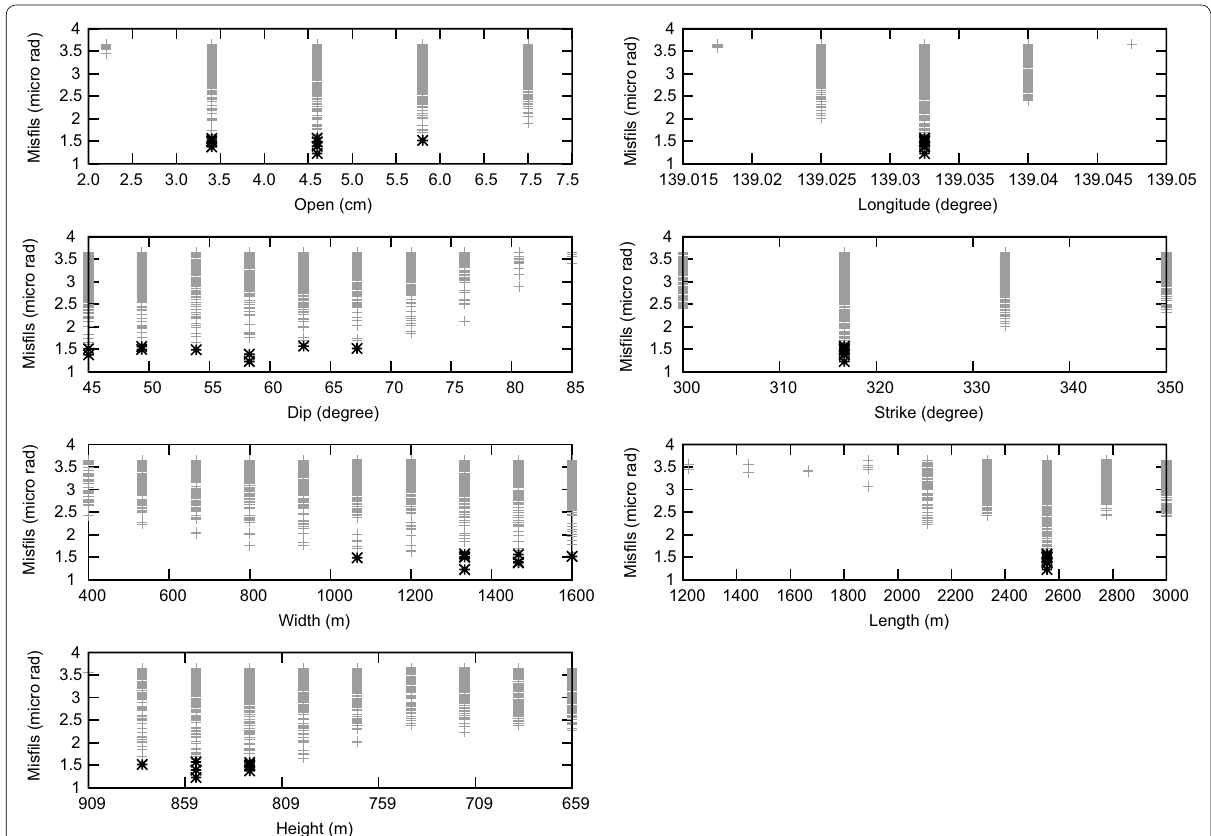
Fig. 7 Parameter distributions for the source models with misfits less than 3.6. Black asterisks indicate top 10 source models with small misfits. The resolution for height, width, and dip angle are relatively poor, indicating that the constraint of crack expansion toward depth is not good. The results for latitude are not shown because the value did not change in this range of